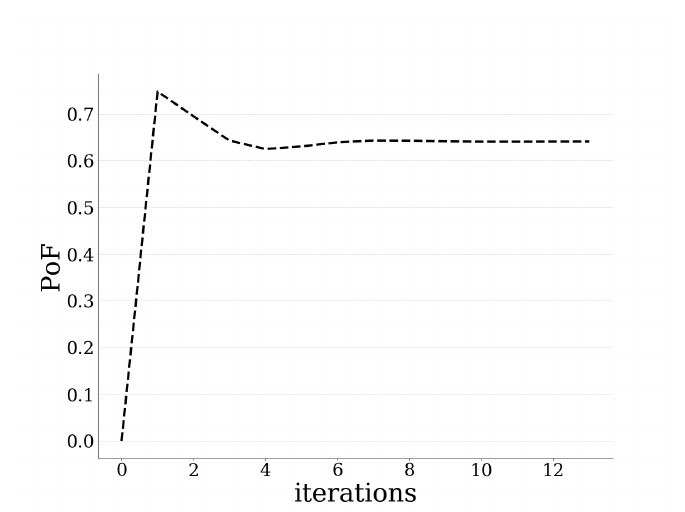
Figure 7. Probability of failure of MEC server vs.